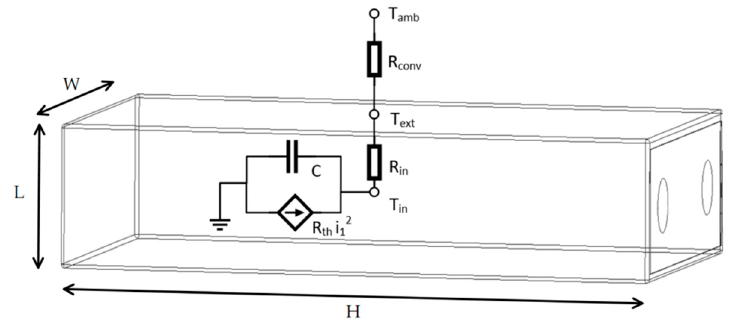
Figure 2. Geometric and thermic representation of a single cell.